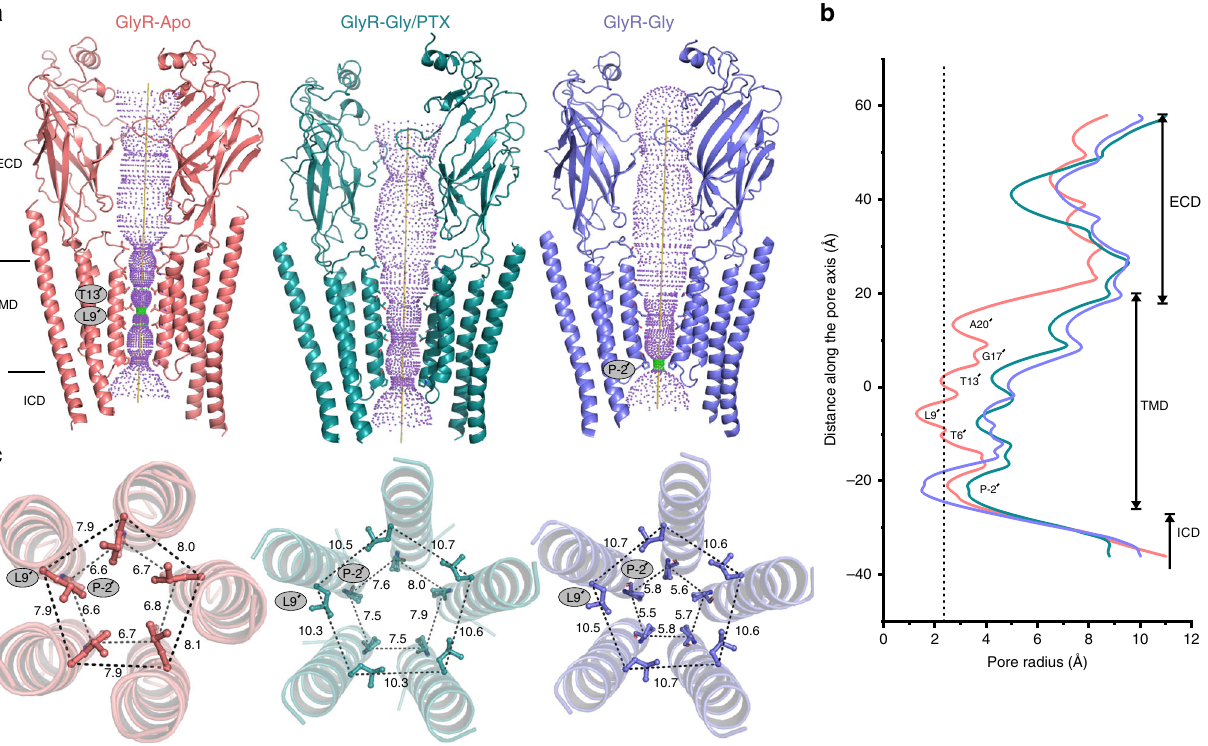
Fig. 1 Cryo-EM structures of full-length GlyR in multiple conformational states. a Ion permeation pathway generated with HOLE 60 for GlyR – Apo (salmon red), GlyR – Gly/PTX (deep teal) and GlyR – Gly (slate blue). For clarity, the cartoon representation of only two non-adjacent subunits are shown. Green and purple spheres de fi ne radii of 1.8 – 3.3 Å and >3.3 Å, respectively. The residues located at various pore constrictions are shown as sticks. b The pore radius is plotted as a function of distance along the pore axis. The dotted line indicates the approximate radius of a hydrated chloride ion, which is estimated at 2.26 Å. c A view of M2 helices from the extracellular end for the three GlyR conformations. Positions Leu9 ′ and Pro-2 ′ are shown in ball-and-stick representation and the corresponding distances between C α are given in